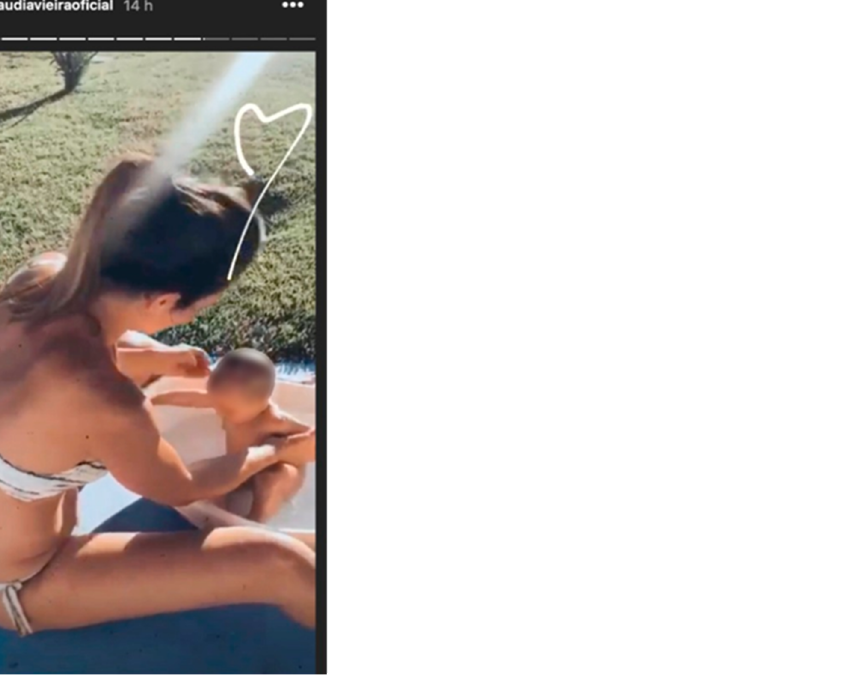
Figure 6. Example of “Embarrassing Moments”; Instagram @claudiavieiraoficial, Instastory, 27 May 2020.